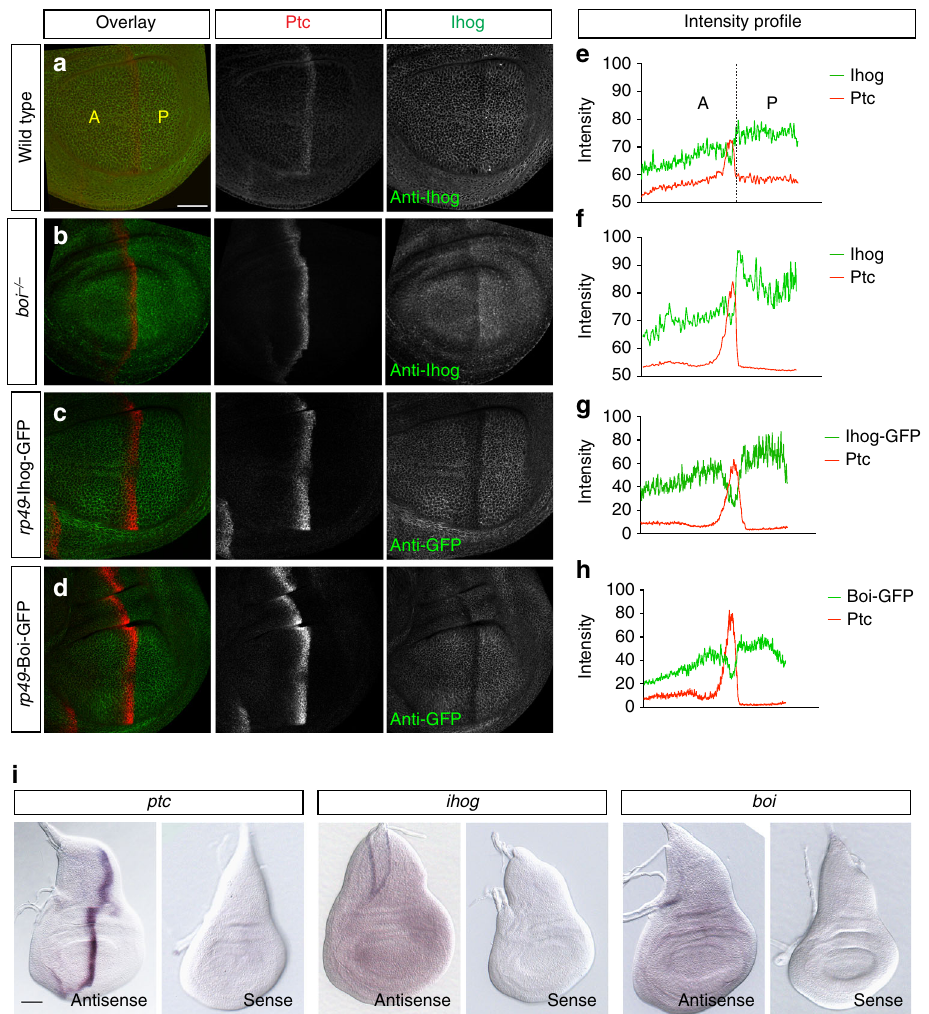
Fig. 5 Ihog is post-transcriptionally downregulated at AP boundary. a , b Wing imaginal disc from wild-type ( a ) or in boi homozygous ( b ) larvae were immunostained for Ihog (green) and Ptc (red). Lower Ihog levels were detected in the A compartment, and lowest levels occur in the Ptc-expressing cells adjacent to the A/P compartment boundary. c , d Wing imaginal discs from larvae carrying rp49-Ihog-GFP or rp49-Boi-GFP immunostained for GFP (green) and Ptc (red). Scale bar, 50 µ m. e – h Plotted pixel intensities of Ptc and Ihog or GFP as a function of A/P position. i Whole mount in situ on third instar wing imaginal discs to show the distribution of ptc , ihog , and boi transcripts. Scale bar, 50 µ